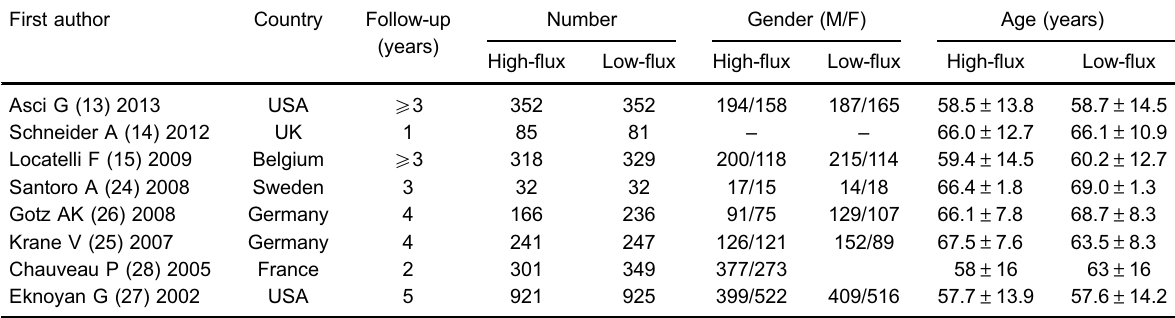
Table 1. Characteristics of included cohort studies focusing on the association between high- fl ux hemodialysis, low- fl ux hemodialysis, and the death rate of patients with acute and chronic renal failure.